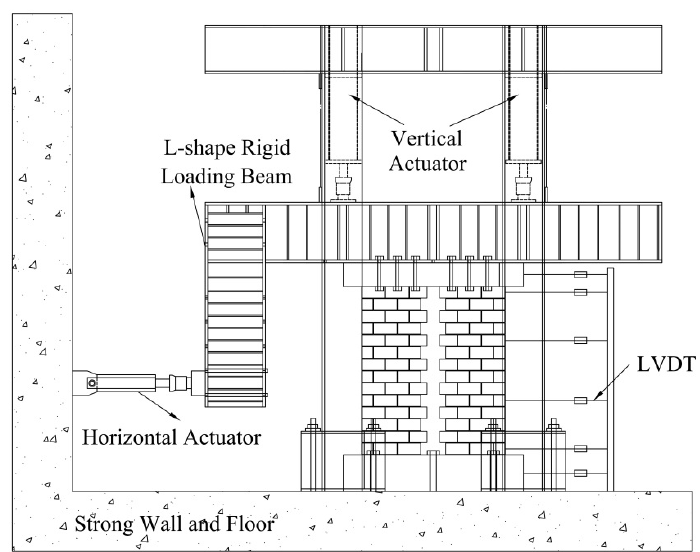
Figure 4. Test setup and instrumentation .